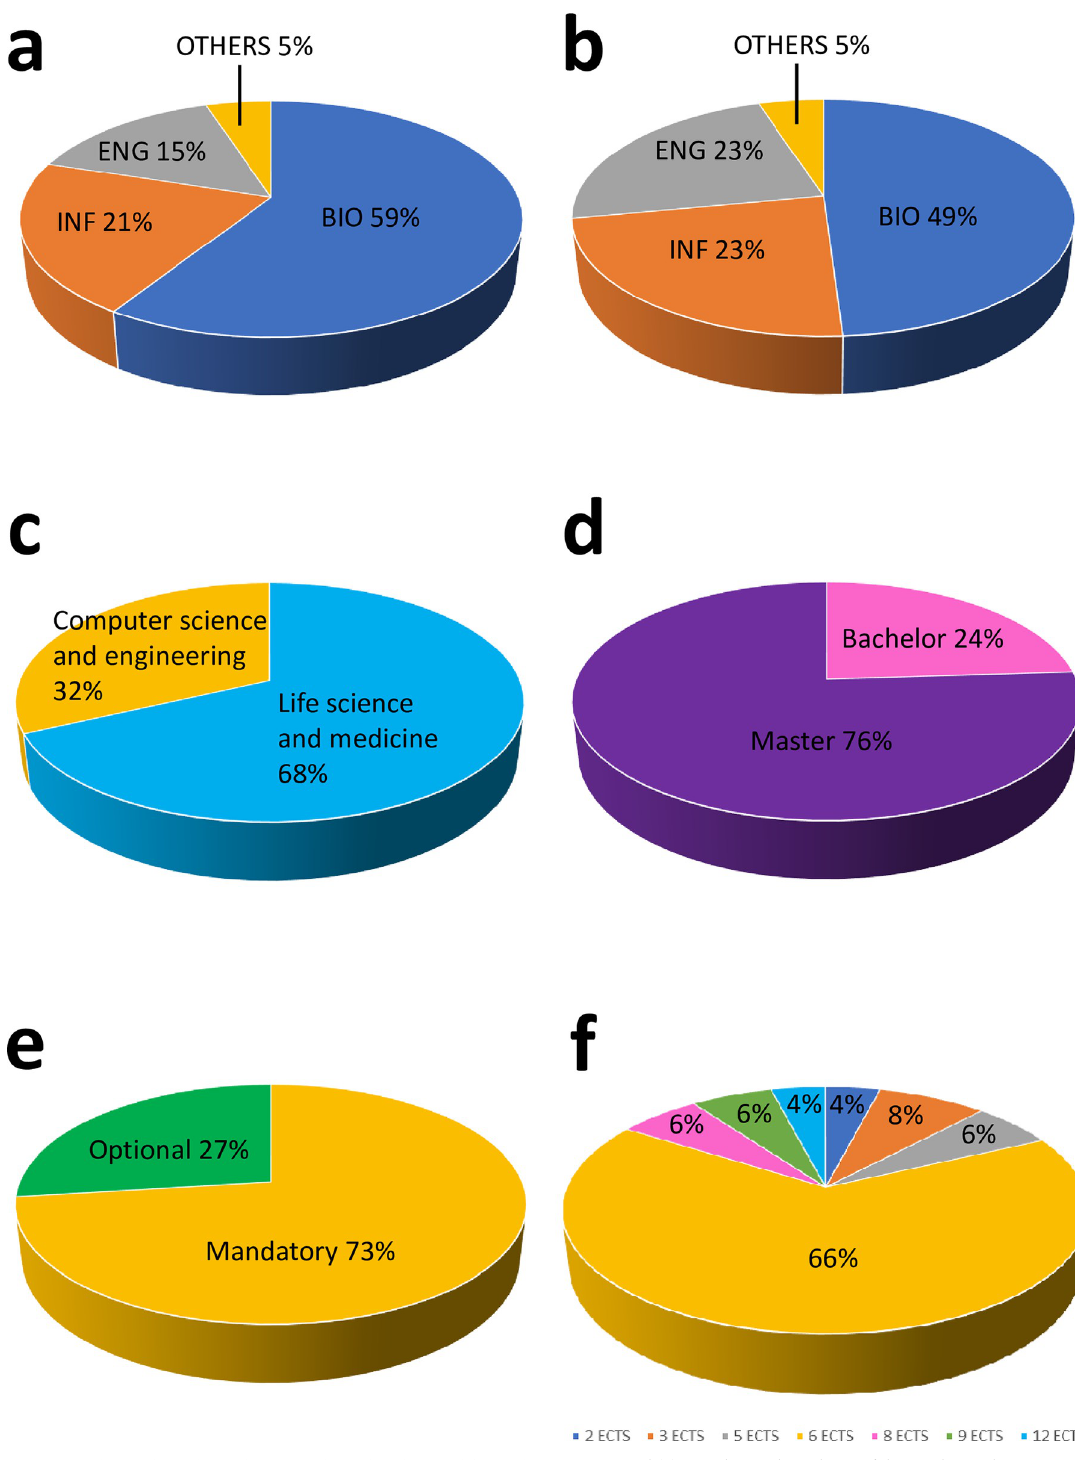
Fig 1. Pie charts describing the general results obtained from the survey. Panel (a): Academic disciplines of the teachers who responded to the survey. BIO: life science/medicine disciplines; INF: computer science disciplines; ENG: engineering disciplines; Others: other scientific disciplines. Panel (b): Academic disciplines attributed to the bioinformatics courses. Label meaning is the same as in panel (a). Panel (c): Scientific area to which the study path in which the bioinformatics course is delivered belongs. Panel (d): Degree level in which the bioinformatics course is delivered. Panel (e): Type of the course (either mandatory or optional). Panel (f): ECTS attributed to the bioinformatics courses reported in the survey.